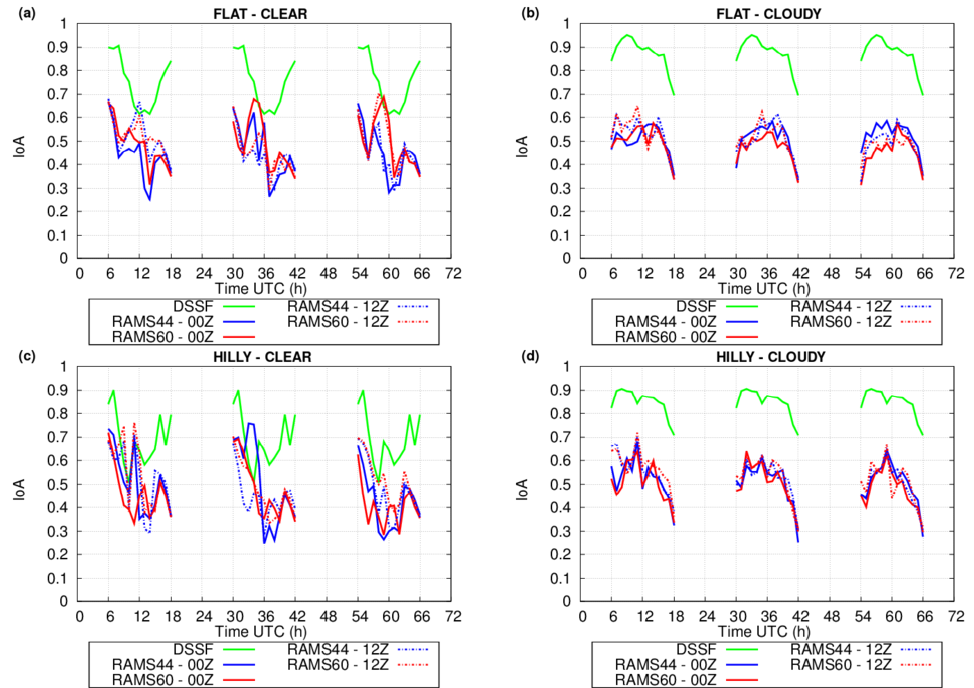
Figure 10. Same as Figure 6, but for the IoA statistical score: flat-clear ( a ); flat-cloudy ( b ); hilly-clear ( c ) and hilly-cloudy ( d ).